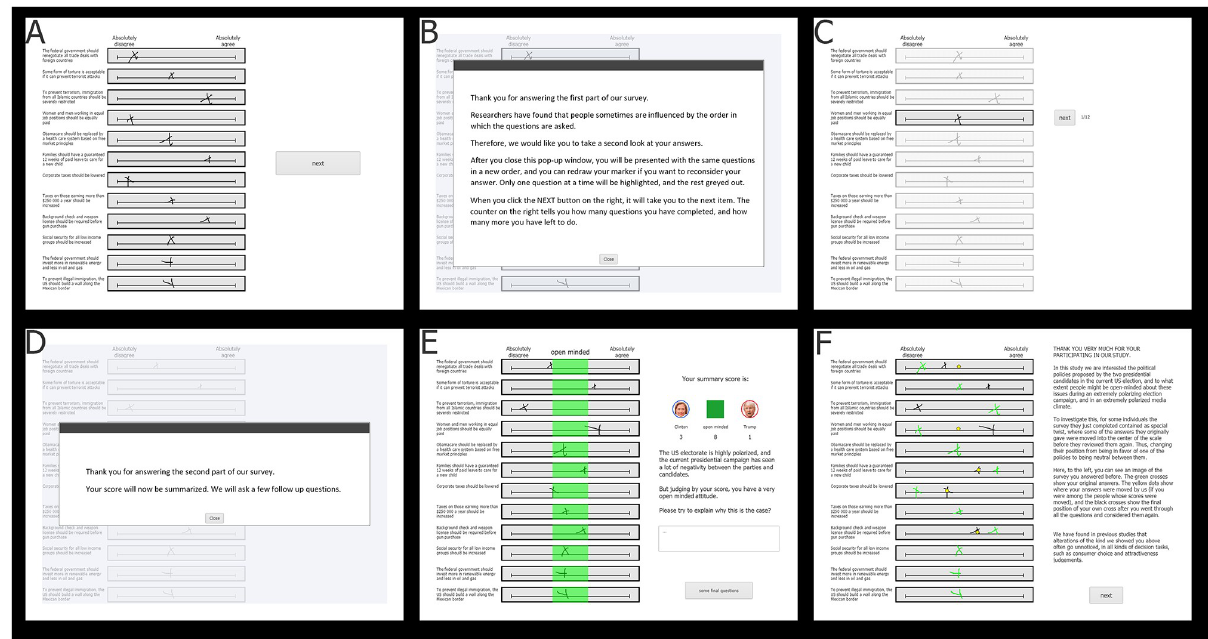
Fig 3. Online survey. Participants rated Hillary Clinton and Donald Trump on 12 leadership traits (A) . They were then instructed to look over their responses and were told that they could change any response by drawing a new one (B) . The items were presented one by one with the rest blurred. Participants in the experimental group received five manipulations that moved each response to a more moderate position (C) . Participants were then told that their score would be summarized (D) . They received a score showing how many of their ratings were in each of the three categories (Clinton, Trump, and open-minded). They were also told their degree of open-mindedness based on the number of their responses in the green middle segment and were asked to explain this in text (E) . They then rated their overall preference for the candidates (F) .